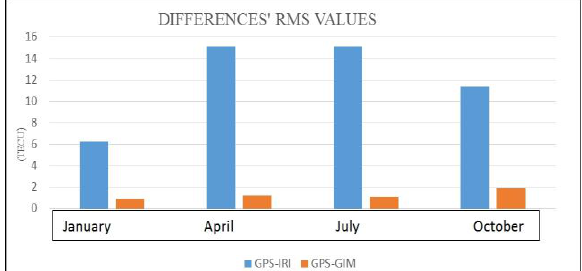
Figure 4. Differences between RMS